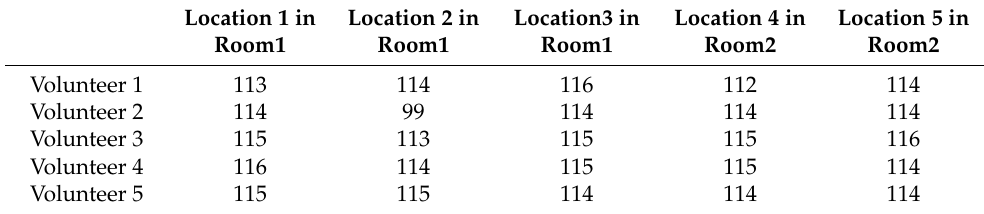
Table 4. The number of gestures collected by each volunteer in each location.